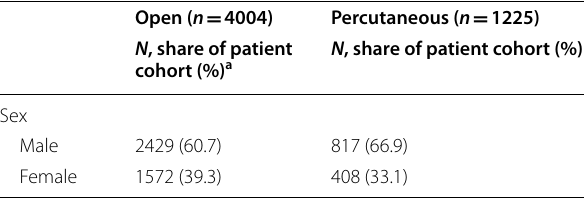
a 3 patients in this cohort did not have listed information on sex